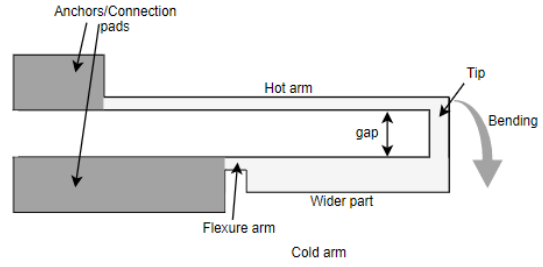
Figure 12. Schematic diagram of design C.